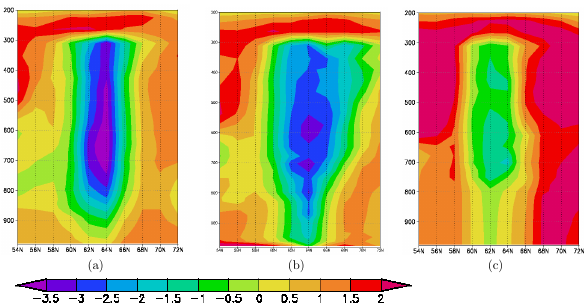
Fig. 12. Cross section of CO 2 differences between the assimilation Figure 12: Cross section of CO 2 differences between the assimilation and the simulation, along latitude lines that follow the local maximum difference on July 1, 0Z, 135 o W (a); July 1, 12Z, 130 o and the simulation, along latitude lines that follow the local maxi- W (b) and July 2, 0Z, 125 o W (c). mum difference on 1 July, 0Z, 135 ◦ W (a) ; 1 July, 12Z, 130 ◦ W (b) and 2 July, 0Z, 125 ◦ W (c) .